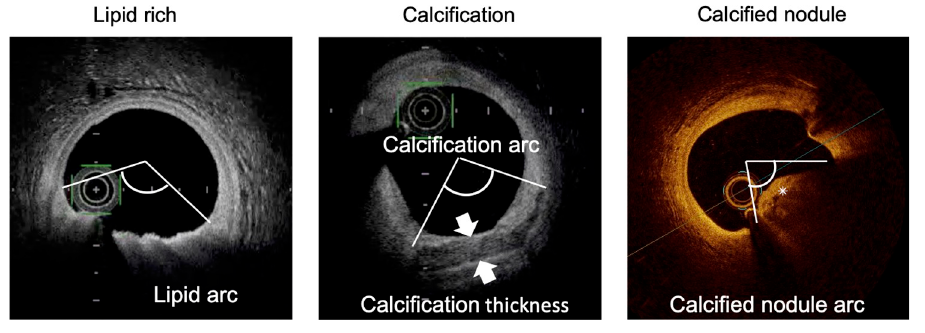
Fig 3. Flow chart of the study